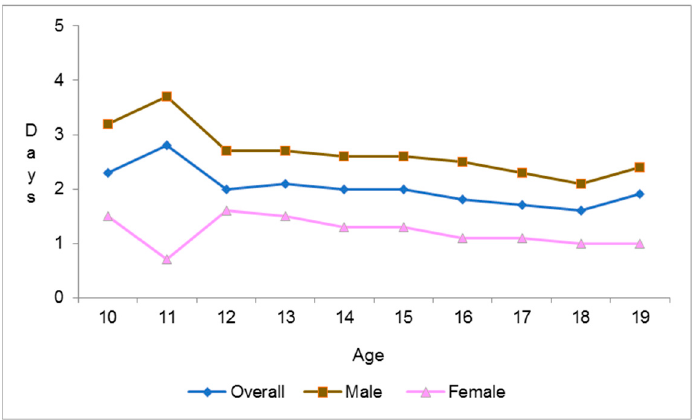
Figure 1. Mean no. of days/week spent on >30 min of physical activity relative to age.